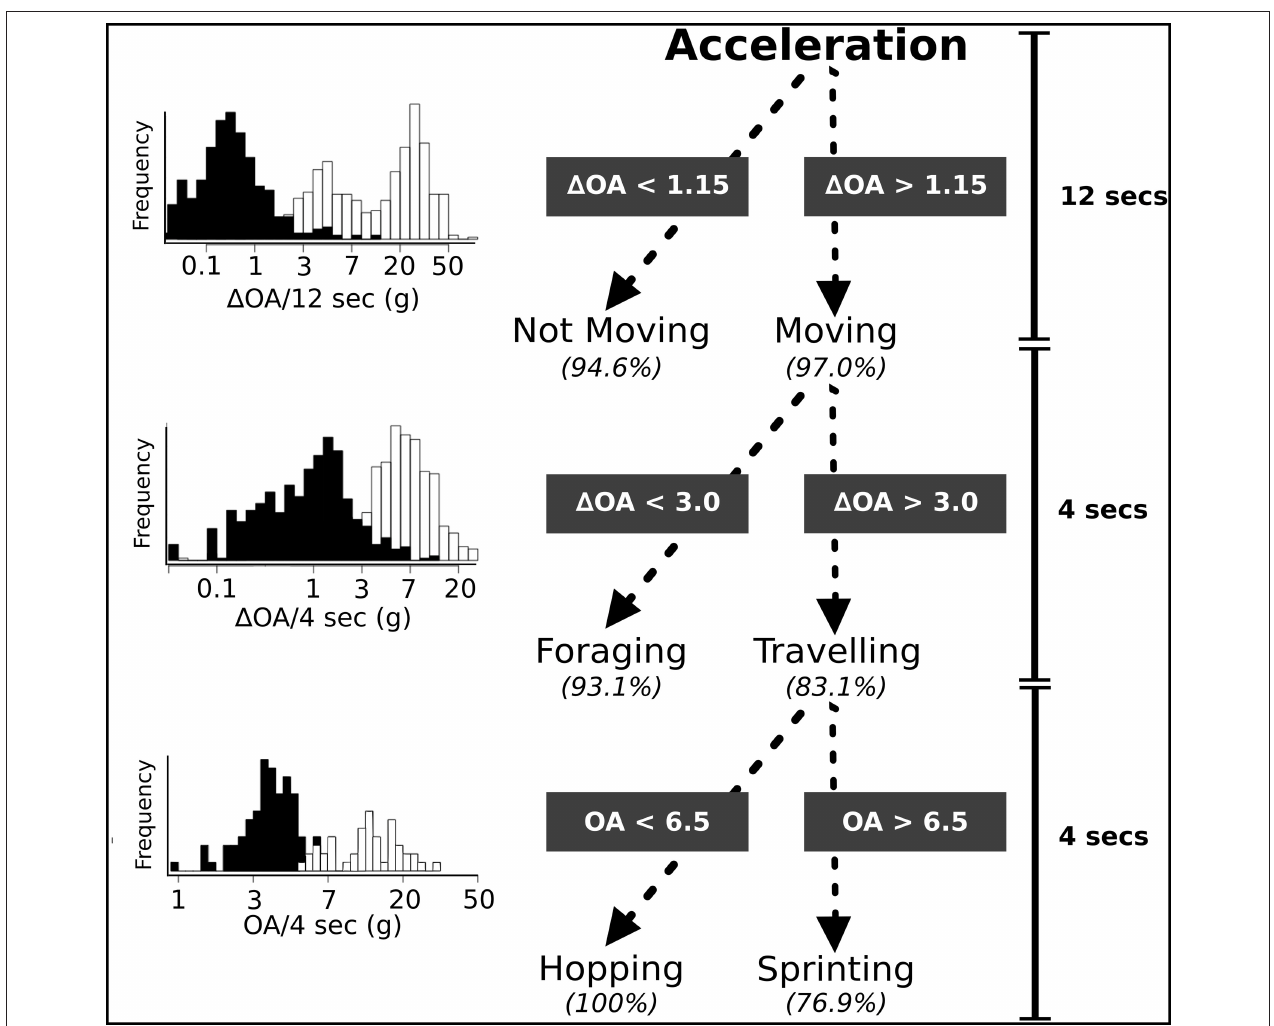
FIGURE 3 | Hierarchal decision tree used to classify snowshoe hare accelerometer data to four behavioral categories. Long duration behavioral states were classified using a 12s window, while short duration behavior was classified using a 4s window. The accuracy of each division is the percentage of observed behavior that were classified correctly. Histograms depict the frequency of each behavior occurring at different values of the summary statistic used for the division of the tree. Black represents behavior on left side of the decision tree while white is behavior on right side of decision tree at each split.